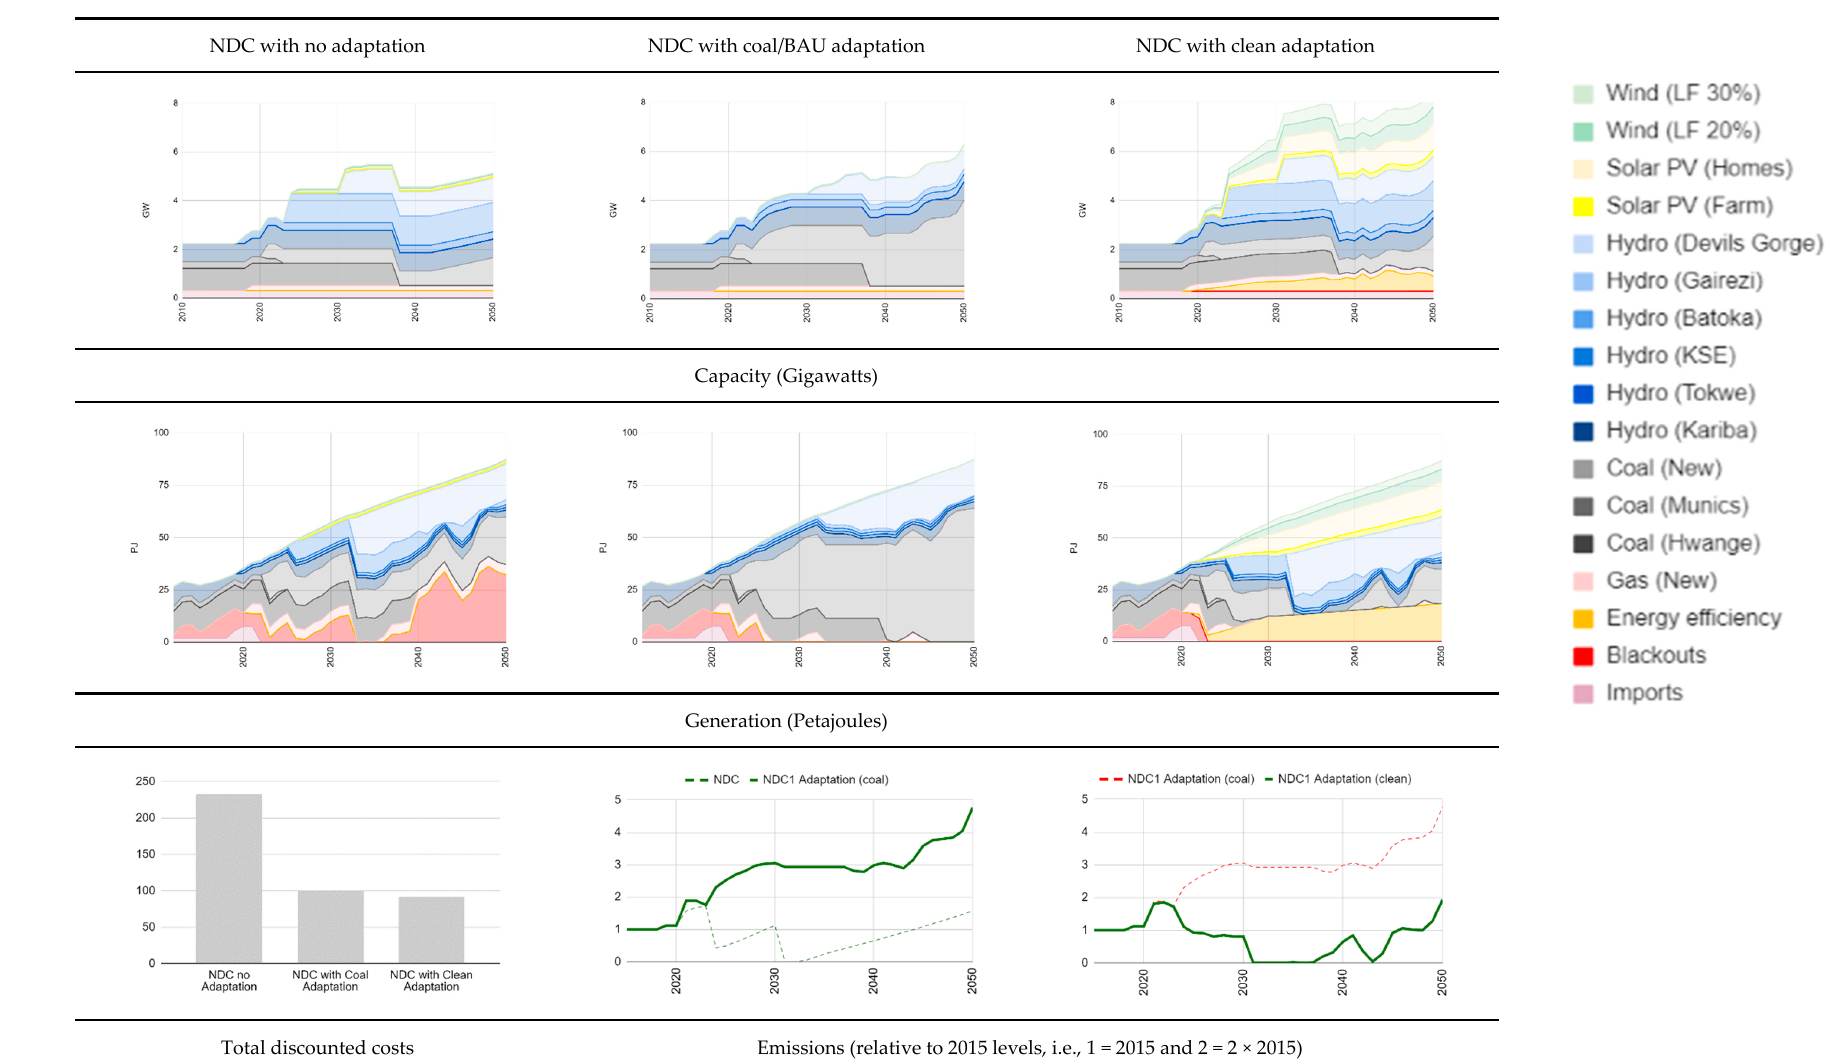
Figure 4. Study Results: NDCs at risk due to climate change (GISS-E2-H climate